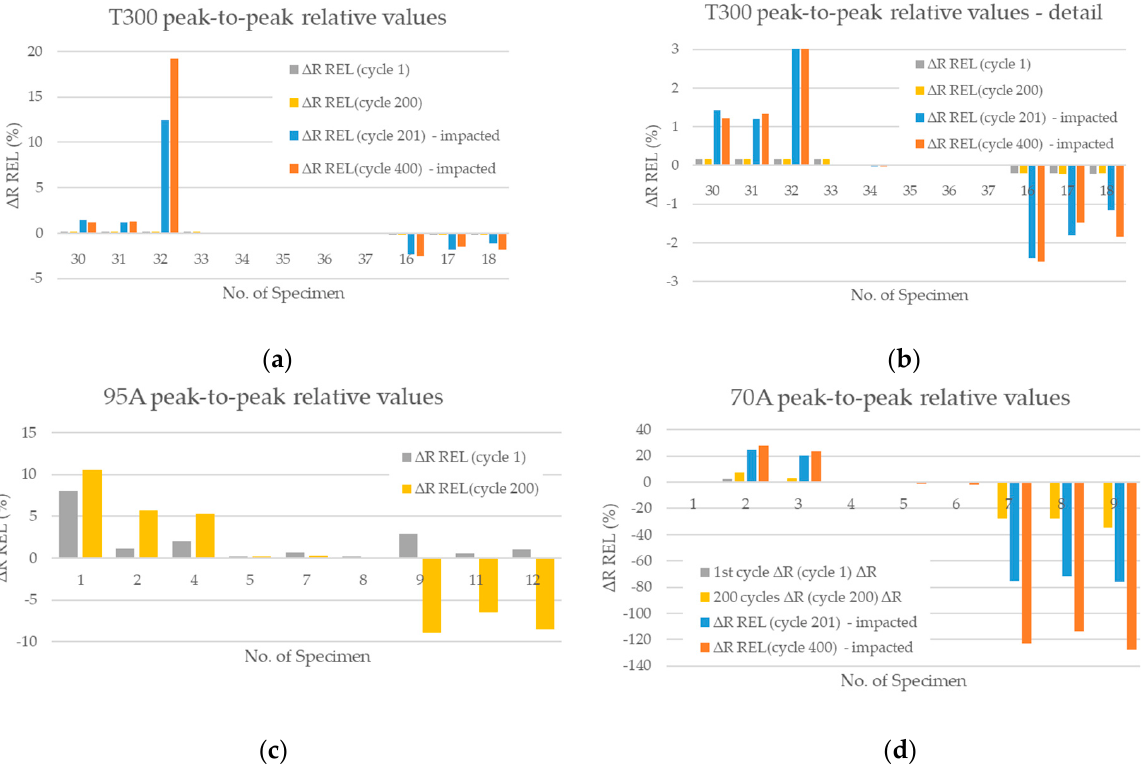
Figure 7. Peak-to-peak relative values of the measured signal from CFSs integrated into the specimens before and after impact loading: ( a ) results for specimens T300; ( b ) results for specimens T300–detail; ( c ) results for specimens 95 A; ( d ) results for specimens 70 A.